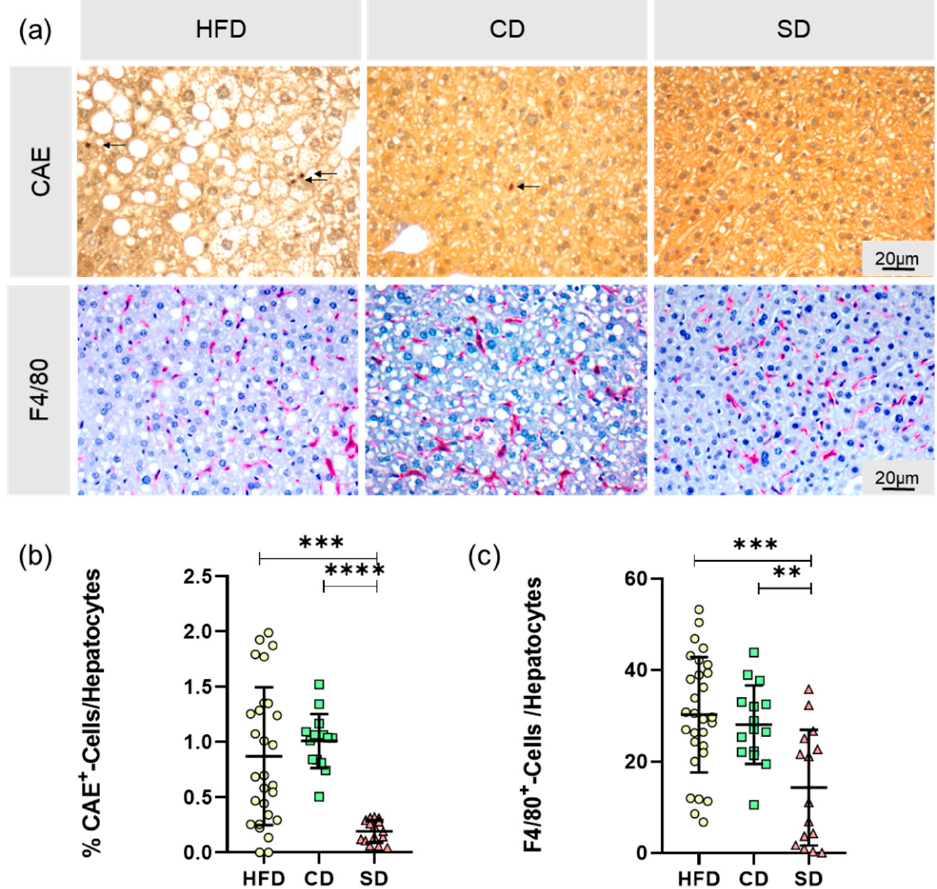
Figure 6. ( a ) Representative images of CAE-staining with CAE + -cells indicated by arrows and F4 / 80-staining with F4 / 80 + -cells stained in red (both at 400 × magnification, scale bar representing 20 µ m valid for all images) of livers from mice fed high fat diet (HFD), control diet (CD) or standard diet (SD); ( b ) Relative amount of granulocytes (CAE + ) (HFD: n = 28; CD: n = 15, SD: n = 15); ( c ) Relative amount of macrophages (F4 / 80 + ) (HFD: n = 29; CD: n = 15, SD: n = 15). Data presented as mean ± standard deviation. Significance of di ff erences between the groups was tested by one-way ANOVA on Ranks (Kruskal–Wallis) in ( b ) or ordinary one-way ANOVA in ( c ); **** p < 0.0001, *** p < 0.001 ** p < 0.01.